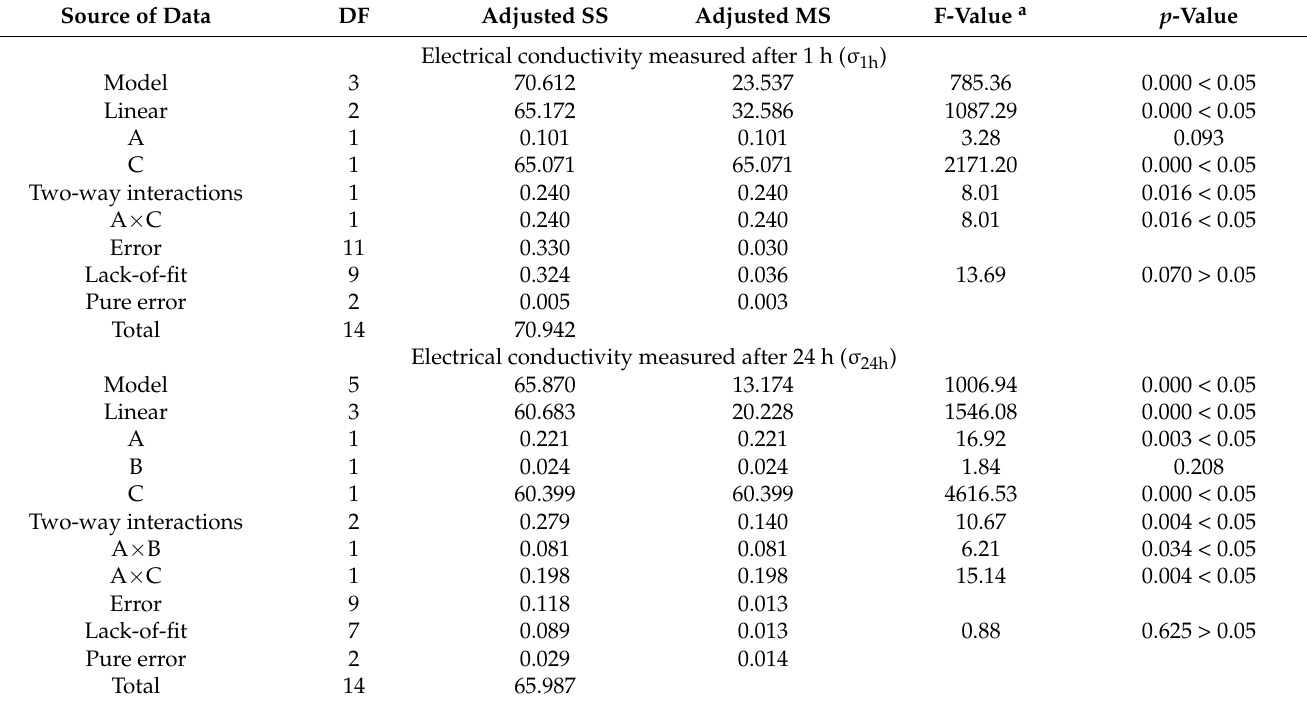
Table 3. ANOVA statistics and results of the lack-of-fit test for the response surface regression models established using the backward-elimination-of-terms algorithm (at α = 0.05) for production of PALs in the continuous-flow FLC-dc-APGD reaction-discharge